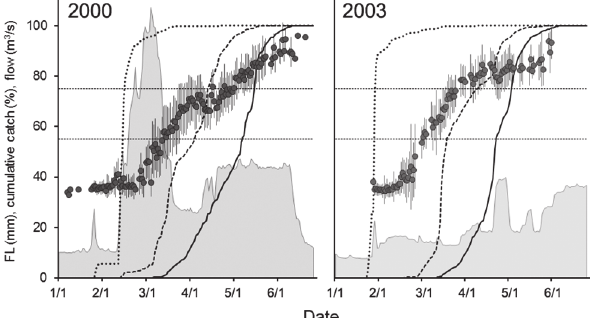
Fig 5. Size and phenology of juveniles outmigrants relative to river flow in 2000 and 2003. Mean ( ± SD) daily fork length (FL) of juvenile outmigrants, and cumulative percentage of fry (short dashed line), parr (long dashed line) and smolt (solid line) outmigrants relative to flow (filled area). Reference lines indicate the size categories used to define the migratory phenotypes: fry ( (cid:1) 55mm), parr (55-75mm) and smolts ( >